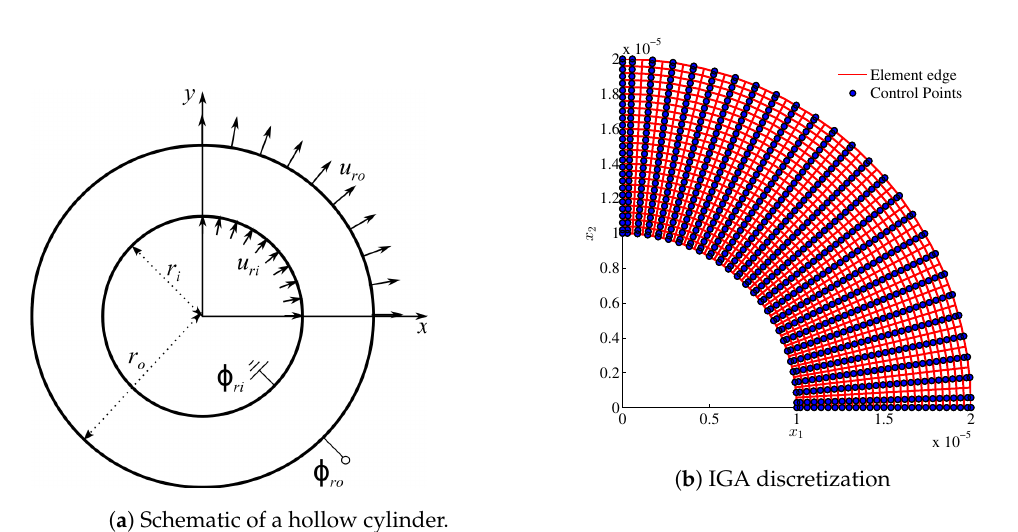
Figure 3. Schematic of an infinitely long hollow cylinder, where the inner and outer radii are r i = 10 µ m and r 0 = 20 µ m, respectively. The inner surface is imposed by radial displacement u r = 0V, whereas the radial displacement u r = 0.05 µ m and electric potential and grounded, i.e., φ r o i = 1V are applied on the outer surface. Symmetry boundary conditions are enforced, such that φ r o (cid:12) (cid:12) (cid:12) (cid:12) (cid:12) (cid:12) = u = u = = u = u = 0 and u u 1 (cid:12) (cid:12) (cid:12) (cid:12) (cid:12) (cid:12) 2 1,2 2,1 1,2 2,1 x 2 = 0 x 2 = 0 x 2 = 0 x 1 = 0 x 1 = 0 x 1 = 0